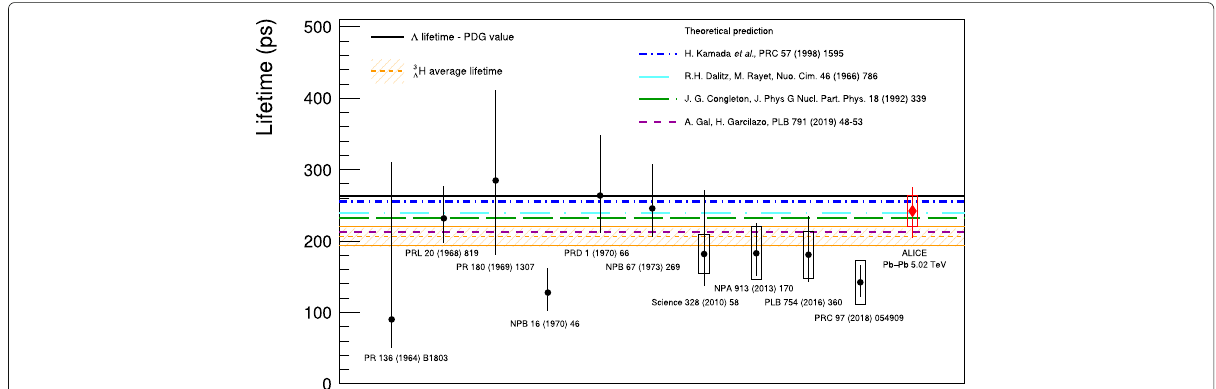
Fig. 5 Collection of the hypertriton lifetime measurements from different experiments [41, 42]. The vertical lines and boxes are the statistical and the systematic uncertainties, respectively. The orange band represents the average of the lifetime values and the lines at the edge correspond to 1 σ uncertainty. The dot-dashed lines are four theoretical